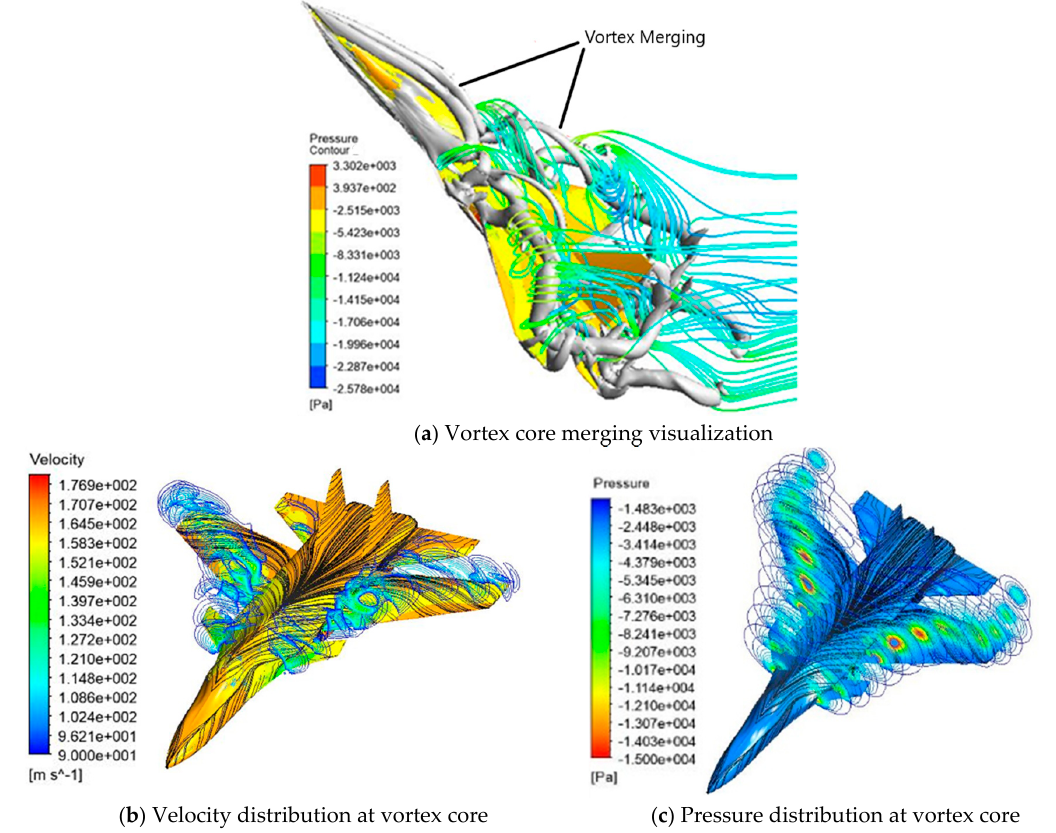
Figure 5. Vortex core visualization in CFD models.